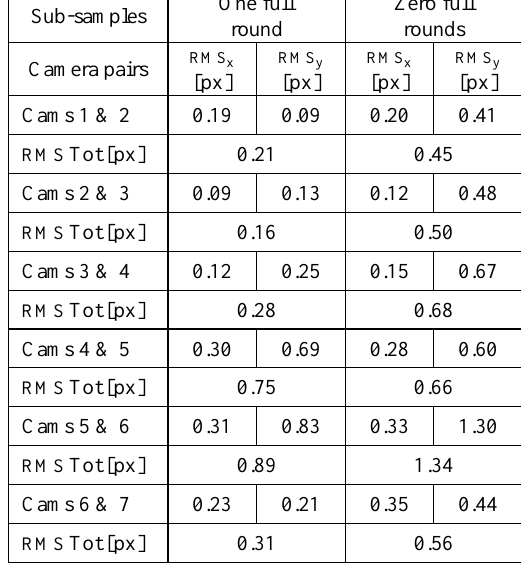
Table 6. Minor calibration results from the system stability analysis comparing the one and zero full round sub- sampled minor calibration data sets with the full major calibration data set Future work will include more testing of the listed methods on different multi-camera systems. In particular, the calibration of a photogrammetric system, whose cameras exhibit near-normal network geometry and whose image footprints do not overlap 100%, will be investigated. Moreover, a method for including all observed epochs, regardless of whether the test field is visible by the reference camera or not, will be Table 4. Summary of the configuration properties and calibration adjustment results for the sub-sampled